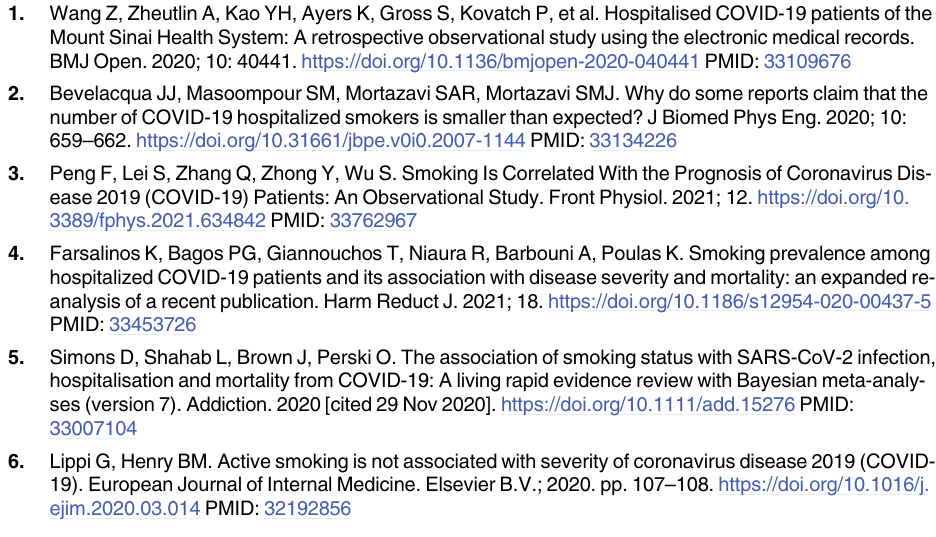
S1 Table. Univariate logistic regression for ICU admission and death among COVID-19 patients as stratified by sex and the Cox proportional hazard regression model. OR = Odds ratio, HR = Hazard